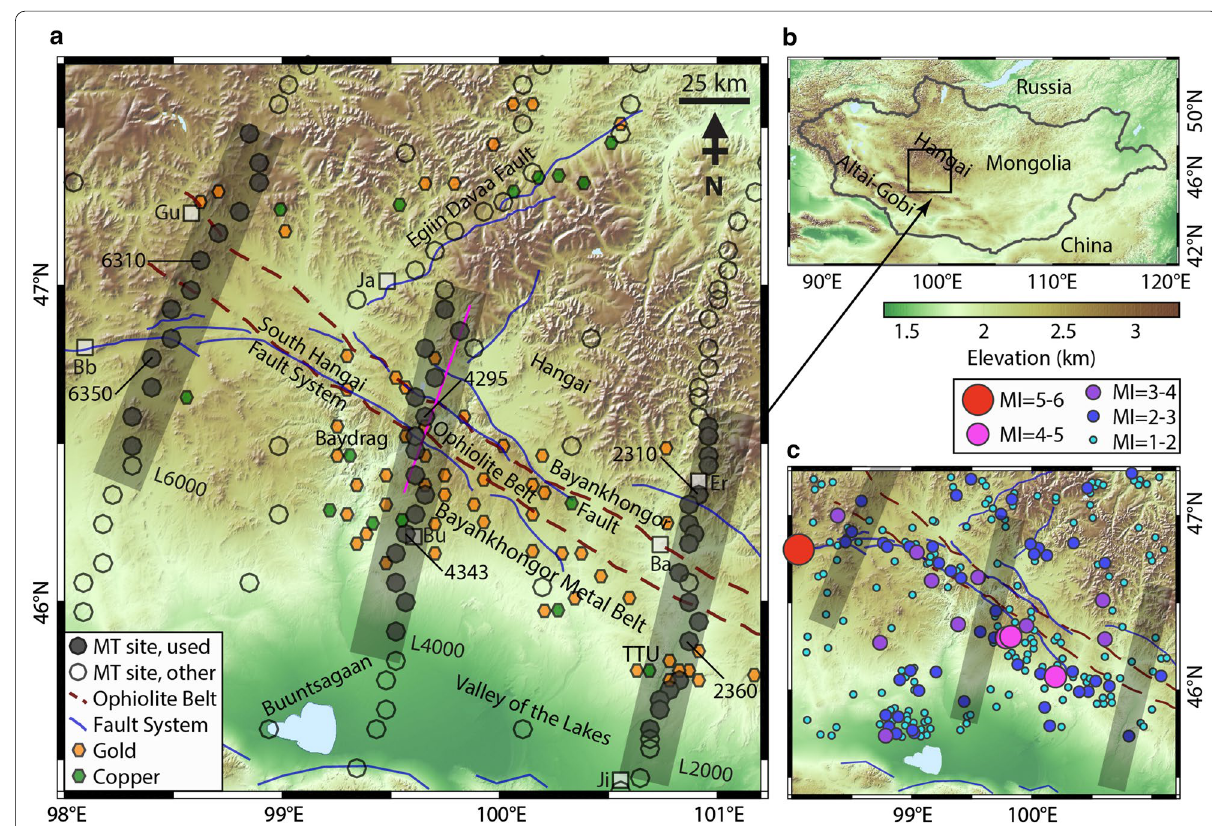
Fig. 1 Topographic map of the study area. a The locations of the MT measurement sites are indicated with black circles; filled circles are used in this study. Each profile is marked with a thick grey line (L2000; L4000; L6000). Specific site names are identified (see Fig. 4). Faults, including the South Hangai fault system, are marked (solid blue lines; Walker et al. 2007; Styron et al. 2018). The approximate location of the Bayankhongor Ophiolite Belt is shown (red dashed lines; Osozawa et al. 2008; Badarch et al. 2002). The location of the geological transect of Osozawa et al. (2008), congruent with L4000, is marked in pink (see Fig. 2). This region contains many mineralized zones, which constitute the Bayankhongor Metal Belt, that contain significant occurrences of copper and gold, identified with green and yellow hexagons, respectively (Mineral Resources Authority of Mongolia 2017; Dejidmaa and Badarch, 1999). Villages are labeled for reference (white boxes; Gu: Gurvanbulag; Bb: Bayanbulag; Ja: Jargalant; Bu: Bumbugur; Er: Erdenestsogt; Ba: Bayankhongor; Ji: Jinst). b The survey area in a regional context. c Distribution of recent seismicity (2012 to 2014; data